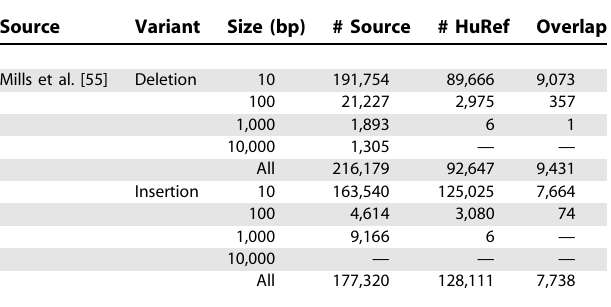
Table 10. Comparison of HuRef Heterozygous Indels to Indel Variants Identified from Other Studies Source Variant